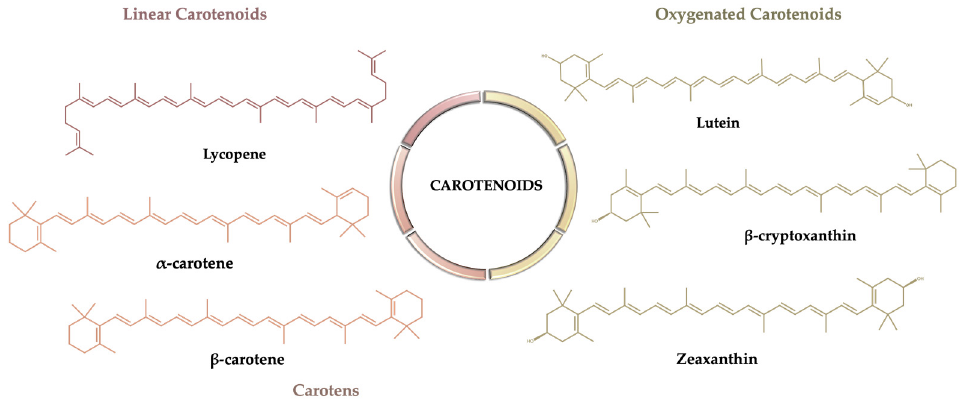
Figure 2 . Chemical structures of the main carotenoids that occur in tomatoes . Figure 2. Chemical structures of the main carotenoids that occur in